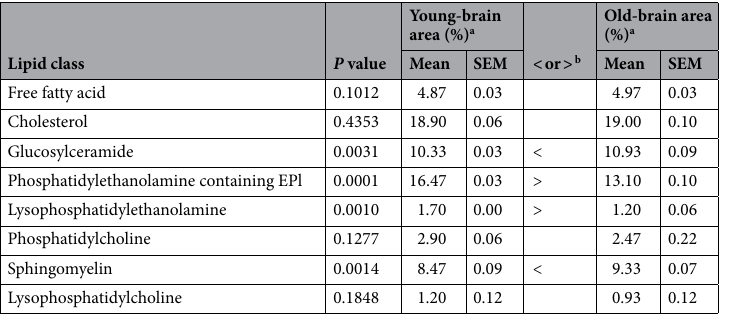
Table 1. Comparison of the ratio of the peak area of each lipid class to the total peak area of all lipids in young and old brains. EPl ethanolamine plasmalogen, SEM standard error of the mean. a Ratio of the peak area of each lipid class to the total peak area. b The ratio was higher ( >) or lower ( <) in young than in old brains. Triplicate analyses were performed for each brain lipid. Statistical analysis was conducted using two-tailed unpaired t -tests. A blue or magenta background indicates a lower or higher ratio, respectively, in old than in young